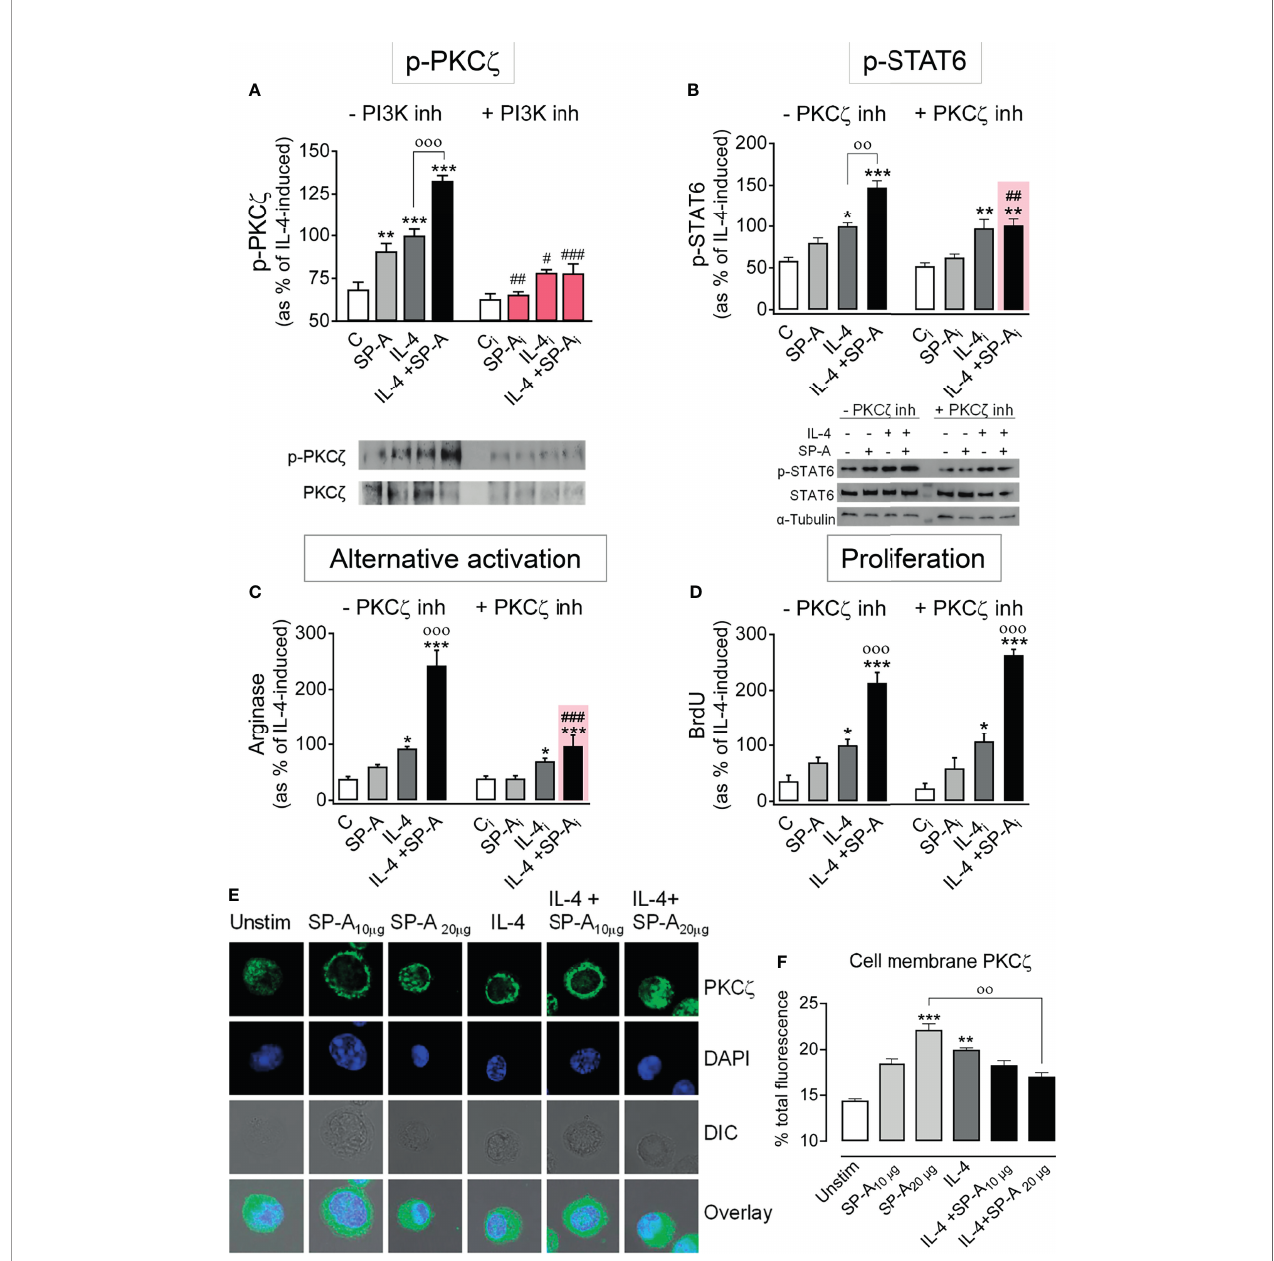
FIGURE 6 | SP-A enhancement of IL-4-induced p-STAT6 and arginase activity is mediated by PKC z . (A) Puri fi ed rat AMs were pretreated with 50 nM LY294002 (PI3K inhibitor) or vehicle for two hours. Subsequently, cells were stimulated with or without IL-4 (1 m g/ml) in the presence or absence of SP-A (100 m g/ml). Then p- PKC z (Thr410/403) relative to total PKC z was quanti fi ed by Western blot. In (B – D) cells were pretreated with 30 µM of PKC z pseudosubstrate inhibitor or vehicle for two hours. Subsequently, cells were stimulated with or without IL-4 (1 m g/ml) and/or SP-A (100 m g/ml). STAT6 phosphorylation relative to total STAT6 (B) , arginase activity (C) , and proliferation (D) of AMs were analyzed. Representative Western blot for p-PKC z or p-STAT6 are shown below each graph. The results are presented as means (± SEM) from three different AM cultures with at least three biological replicates. (E) PKC z plasma membrane localization after IL-4 and/or SP-A stimulation. Representative IF for PKC z localization in AMs from SP-A -/- mice left untreated or treated with IL-4 (0.5 m g/ml) in the absence or presence of SP-A (10-20 m g/ml). Confocal images shown are representative of three independent experiments with similar results. Upper panels show PKC z staining, middle panels show DAPI counterstaining of cell nuclei and differential interference contrast (DIC), lower panels show overlay. (F) Quanti fi cation of pixel density of cell-membrane PKC z from total PKC z values. Data are expressed as percentage ± SEM of three independent experiments with at least 20 cells per condition. Results were statistically analyzed by one-way ANOVA followed by the Bonferroni multiple-comparison test. * p < 0.05, ** p < 0.01, and *** p < 0.001 when compared with untreated macrophages. оо p < 0.01 and ооо p < 0.001 when SP-A+IL-4- treated macrophages were compared with IL-4 or SP-A-treated macrophages. # p < 0.05, ## p < 0.01 and ### p < 0.001 when the effect of PI3K or PKC z inhibitor is compared with the same sample without